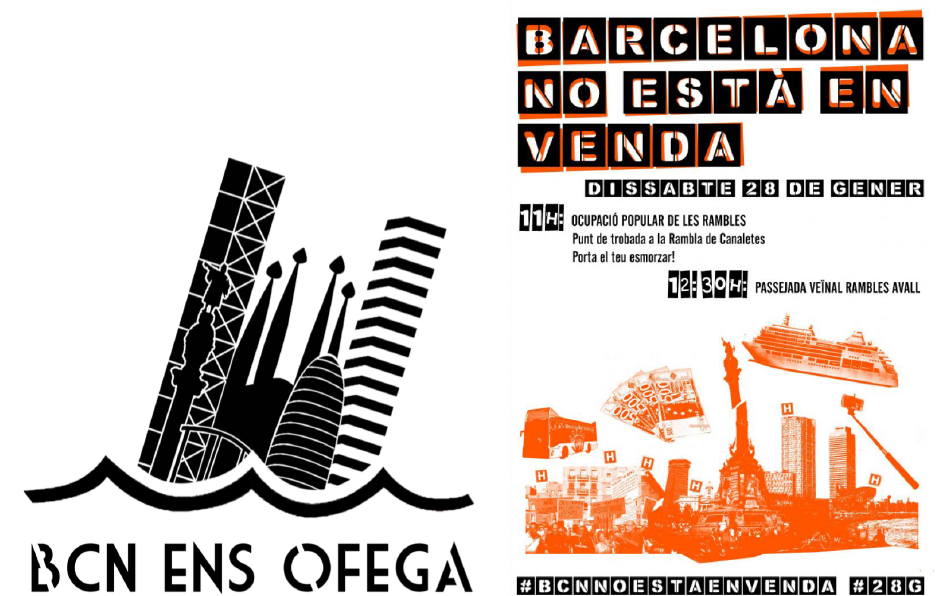
Figure 13. Campaigns against the city commodification and “Barcelona brand”. Source: Bcn Ens Ofega (2016) and SOS Rambla